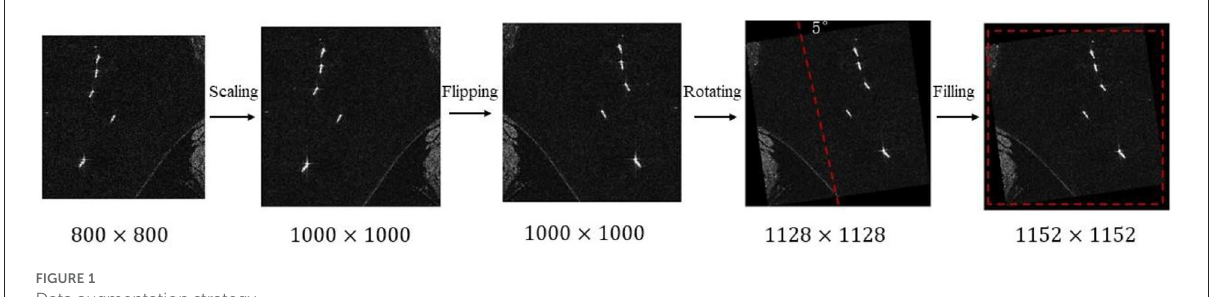
FIGURE1 Data augmentation